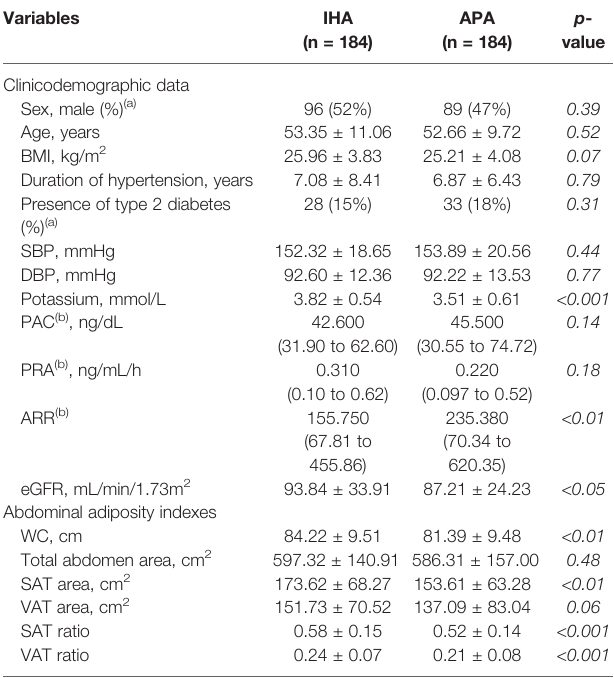
TABLE 2 | Comparison of clinicodemographic data and abdominal adiposity indexes between the IHA and APA groups after propensity score matching for age and